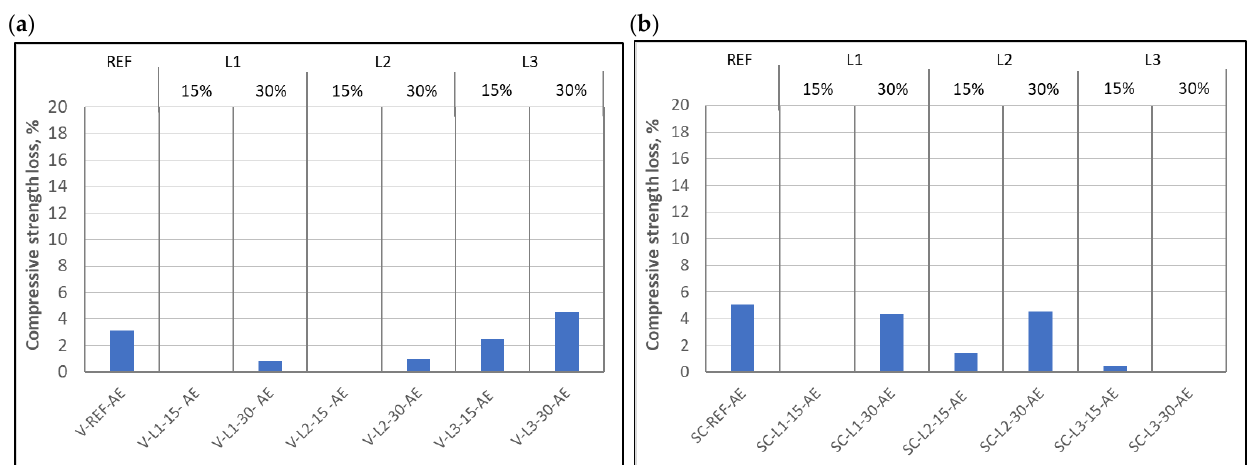
Figure 10. Strength loss for ( a ) vibrated concrete and ( b ) self-compacting concrete, both with air- entraining admixture.